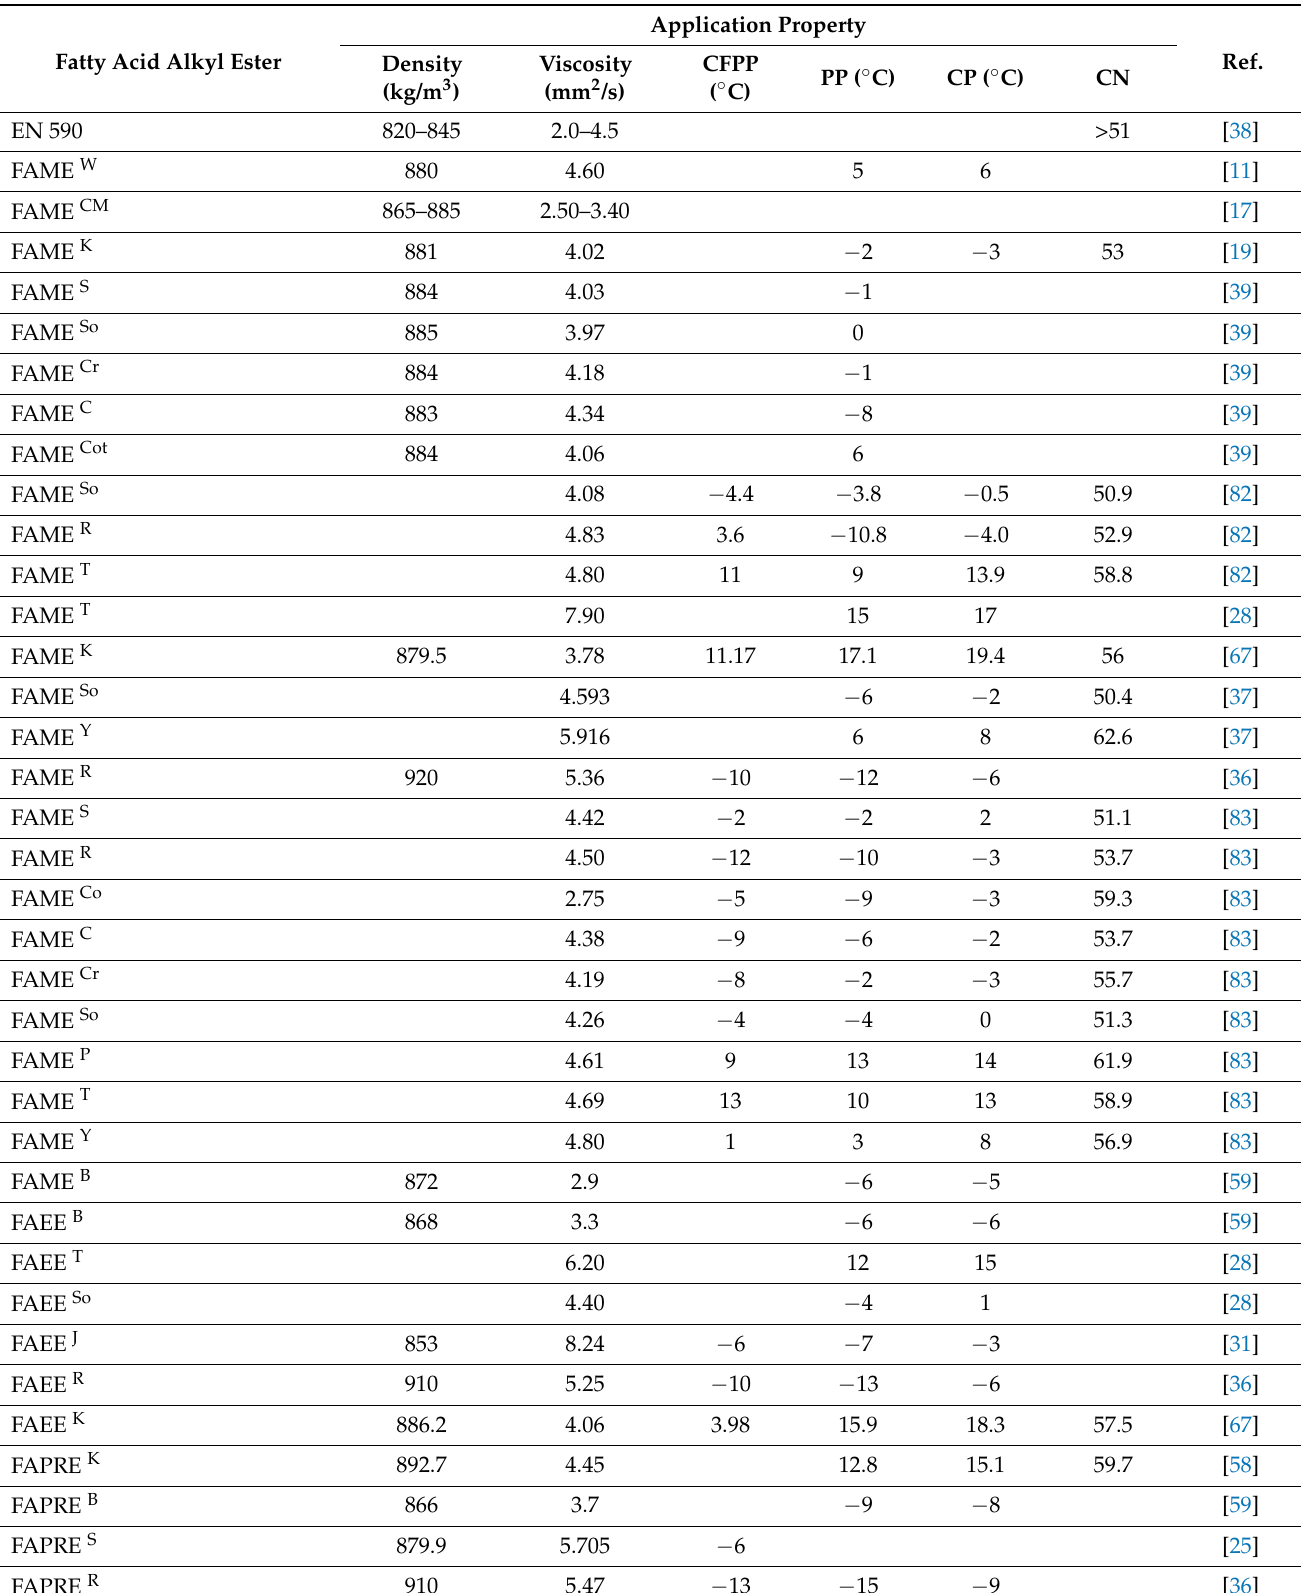
Table 2. Physical properties of different